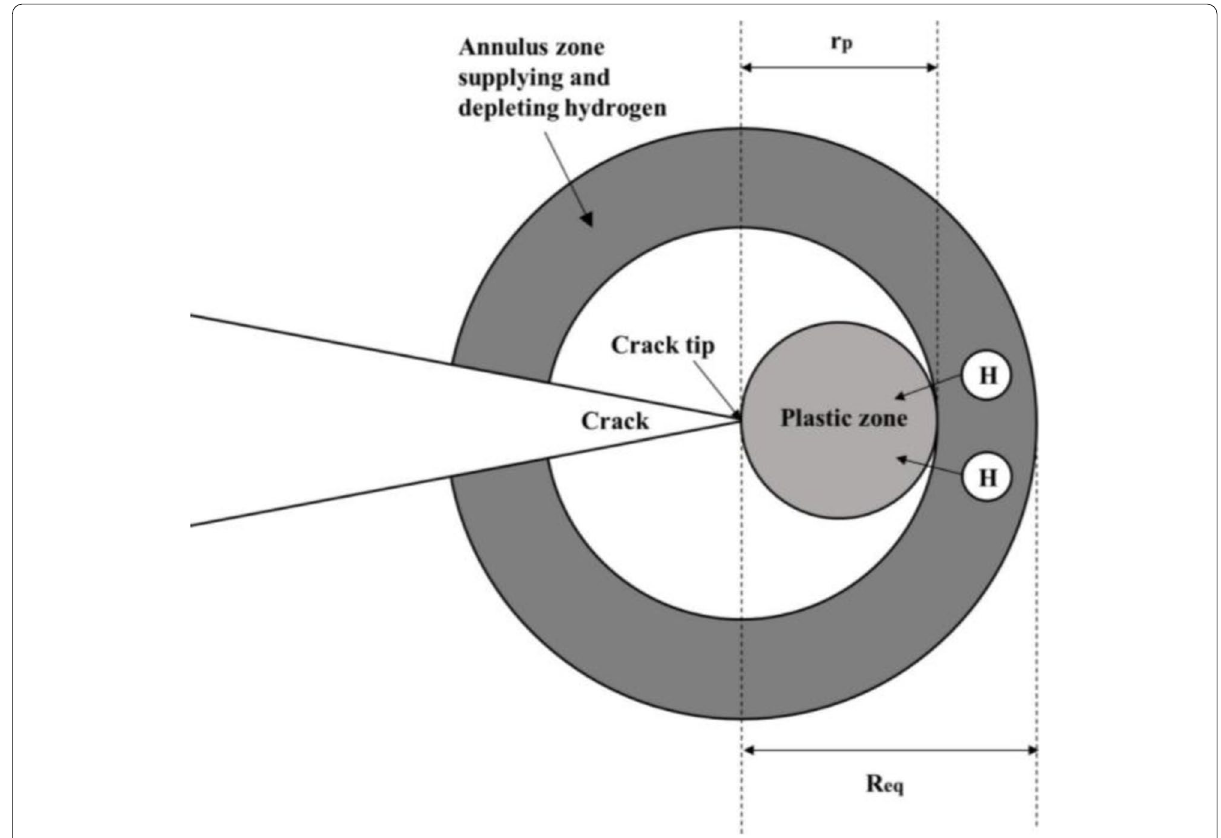
Fig. 1 The schematic of the hydrogen enhanced crack growth model